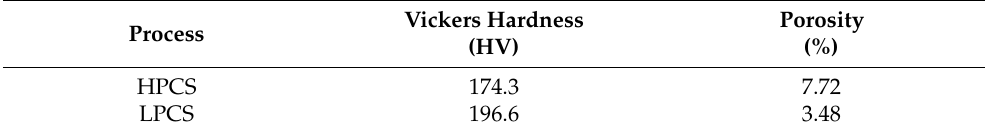
Table 3. Vickers hardness and porosity of HPCS and LPCS coatings.